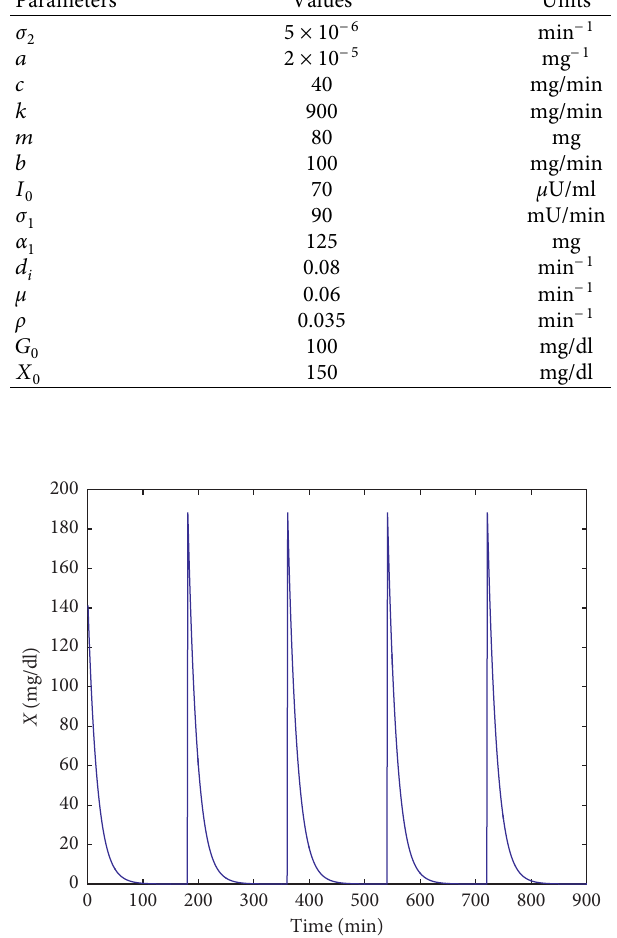
Figure 1: Change of glucose concentration X ( t ) after glucose intake.